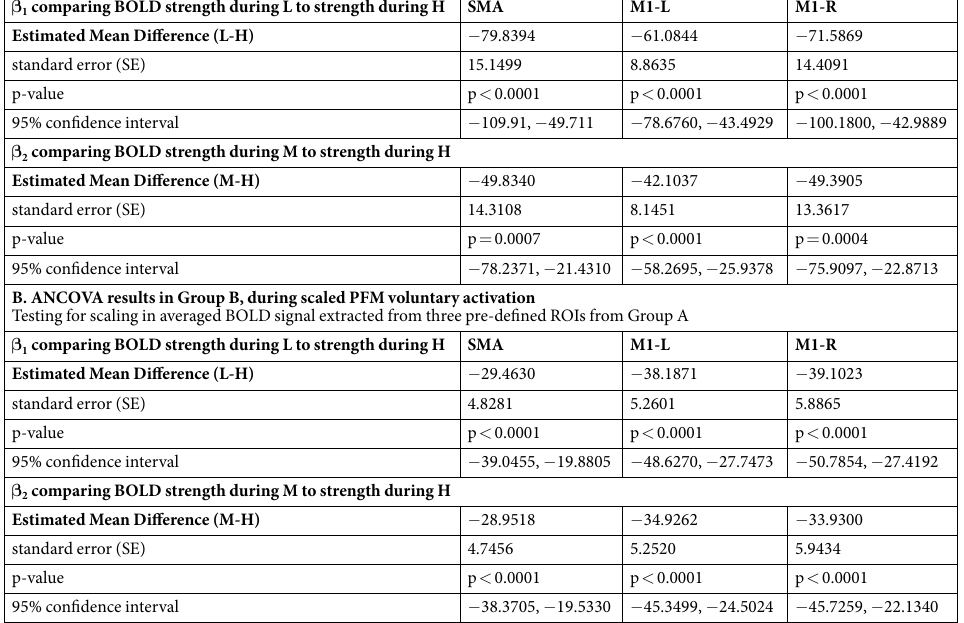
Table 2. Functional MRI (fMRI) BOLD scaling during scaled voluntary muscle activation. Scaling in BOLD signal strength during three distinct levels of voluntary activation, low (L), medium (M), and high (H), is investigated using an ANCOVA model. See MEHODS section. A ij = Intercept + β 1 * L + β 2 * M + 0 * (H) + β 3 * R ij + U i + E ij A ij is the 75 percentile of the pre-assumed Active period, while R ij is the 50 percentile of the preceding pre-assumed Rest period. L is identifier of low activation, M is identifier of medium activation, and H is identifier of high activation. Each participant is assumed to have a unique intercept [Intercept + Ui]. SMA (supplementary motor area); M1-L (primary motor cortex, left hemisphere); M1-R (primary motor cortex, right